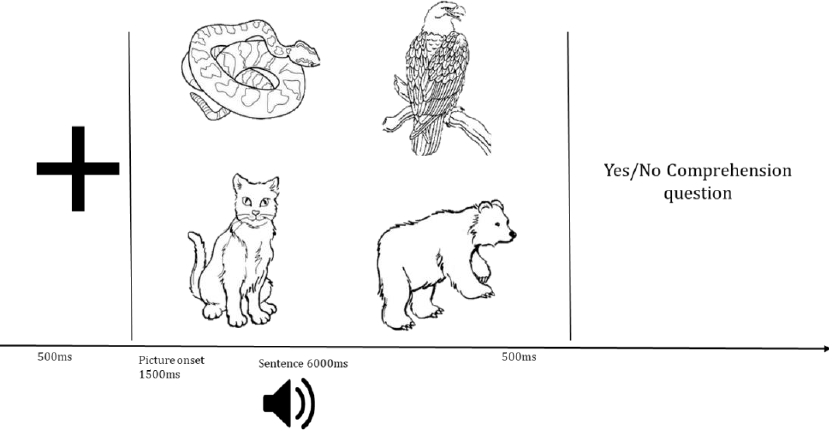
Figure 2. Example of a visual world eye-tracking paradigm. The speaker represents the auditory